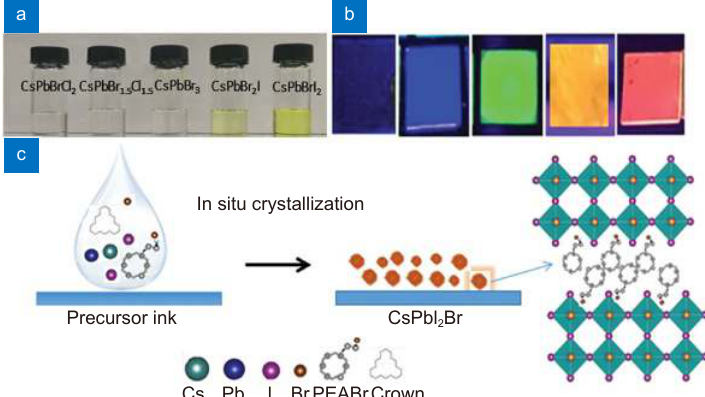
Fig. 8 | ( a ) Photographs of the CsPb X 3 inks. ( b ) CsPb X 3 films with different halide compositions under a 365 nm UV lamp and ( c ) schematic of perovskite transformation from CsPb X 3 ink to CsPb X 3 nanocrystal. Figure reproduced with permission from ref. 19 , John Wiley and